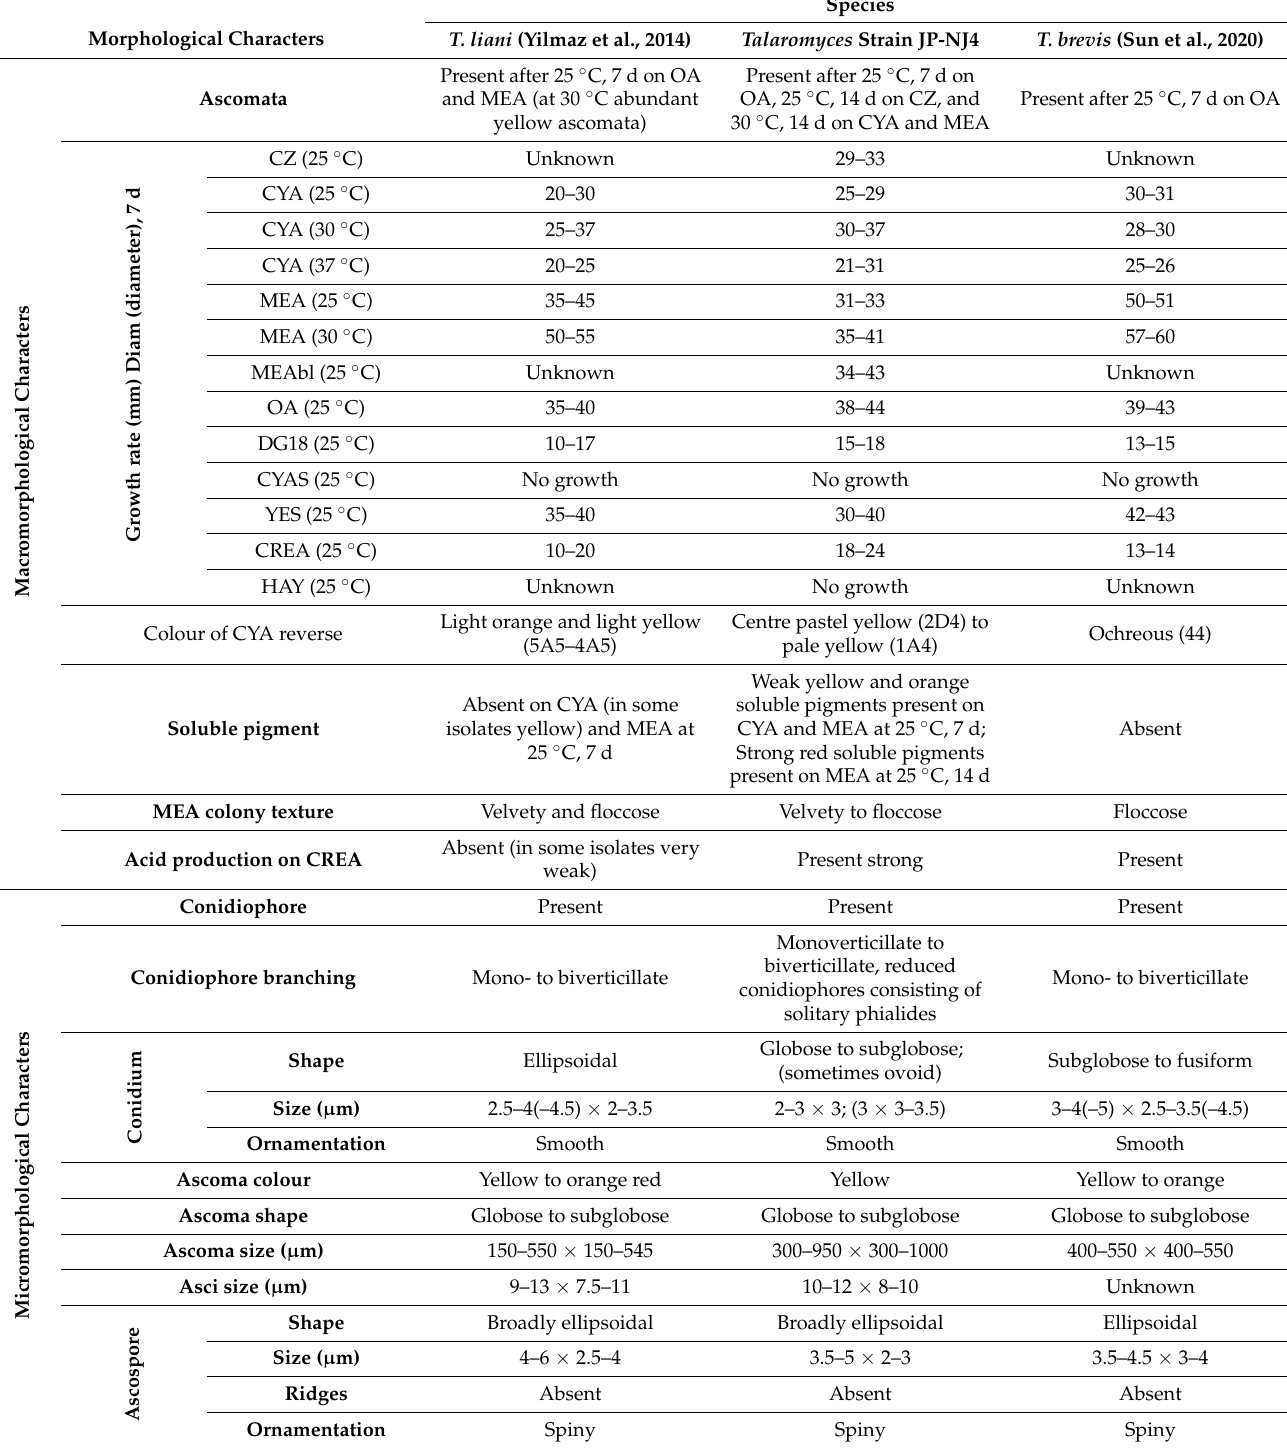
Table 2. Morphological comparison of strain JP-NJ4 with Talaromyces liani and Talaromyces brevis